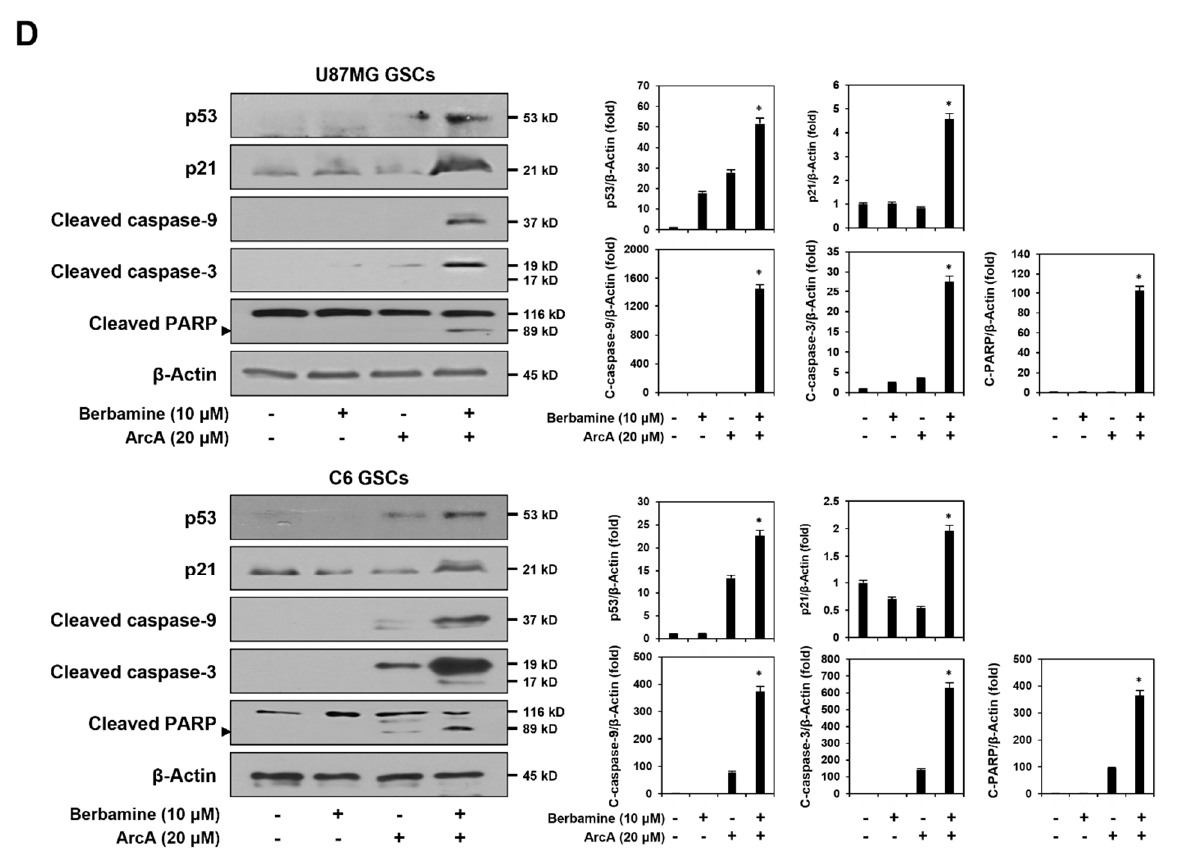
Figure 2. Combined treatment of berbamine and ArcA strongly promotes GSC apoptosis. ( A – D ) U87MG- and C6-derived GSCs were treated with the indicated concentrations of berbamine and ArcA for 24 h. ( A ) Effect of combined treatment of berbamine and ArcA on the nuclear morphology. Changes in nuclear morphology were monitored by DAPI staining under a fluorescence microscope. ( B ) Effect of combined treatment of berbamine and ArcA on the intracellular ROS generation. ROS levels were detected with H 2 DCFDA using a fluorescence microscope and were further quantified by densitometry. The level of DCF fluorescence for untreated control was normalized to 1-fold. ( C ) Effect of combined treatment of berbamine and ArcA on the intracellular calcium level. The levels of calcium were detected with Fluo-4 AM using a fluorescence microscope and were further quantified by densitometry. The level of Fluo-4 AM fluorescence for untreated control was normalized to 1-fold. ( D ) Effect of combined treatment of berbamine and ArcA on the expression of apoptosis regulators. Protein levels were detected by Western blot analysis using specific antibodies and were further quantified by densitometry. β -Actin levels were used as an internal control. The ratio of each target protein to β -actin for untreated control was normalized to 1-fold. * p < 0.05, *** p < 0.001 vs. the compound alone.